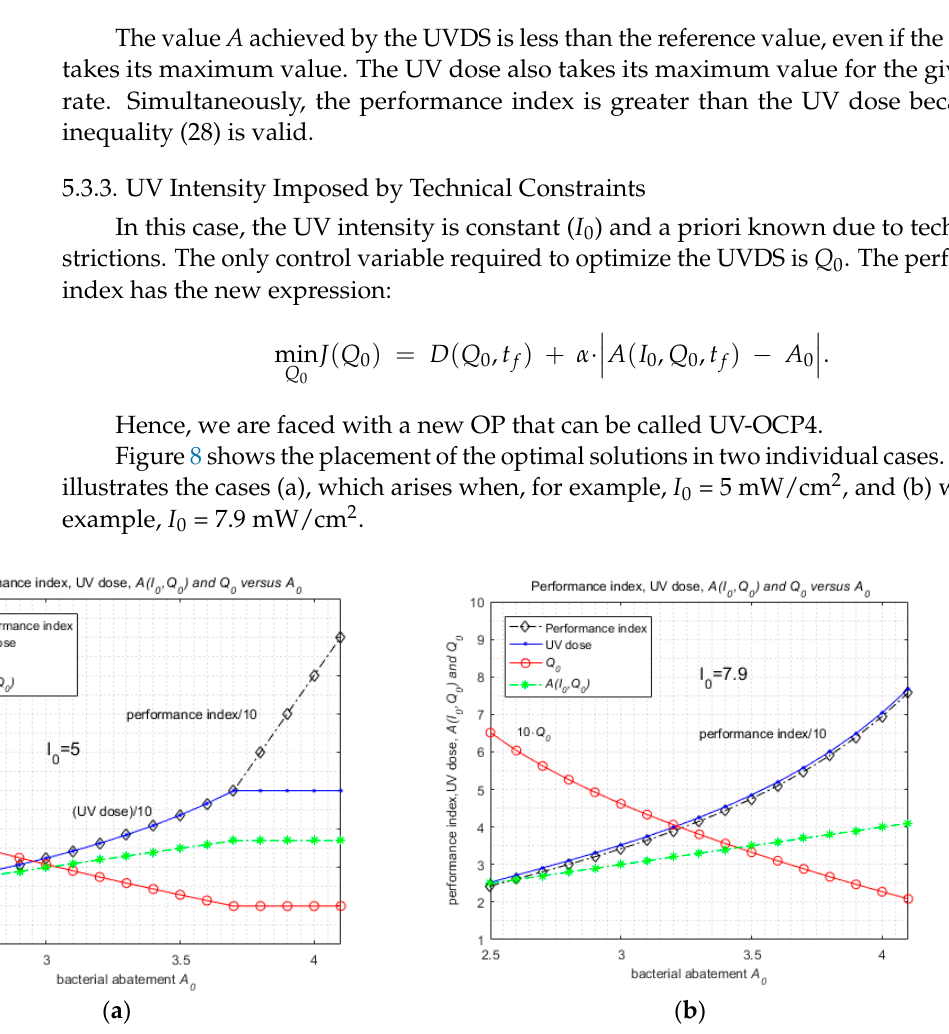
Figure 8. Optimal solutions with an imposed UV intensity: ( a ) I 0 = 5; ( b ) I 0 = 7.9